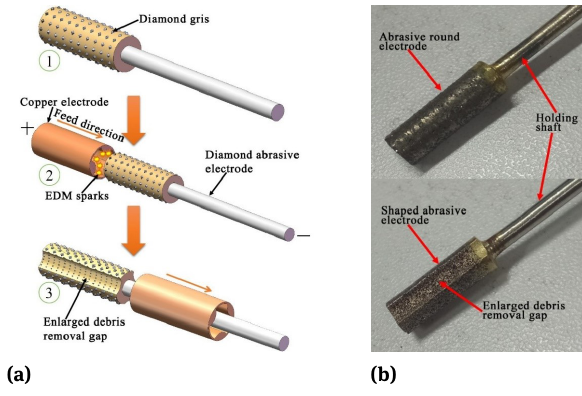
Figure 5: (a) Schematic diagram of preparation of shaped abrasive electrode; (b) Actual photo of the abrasive